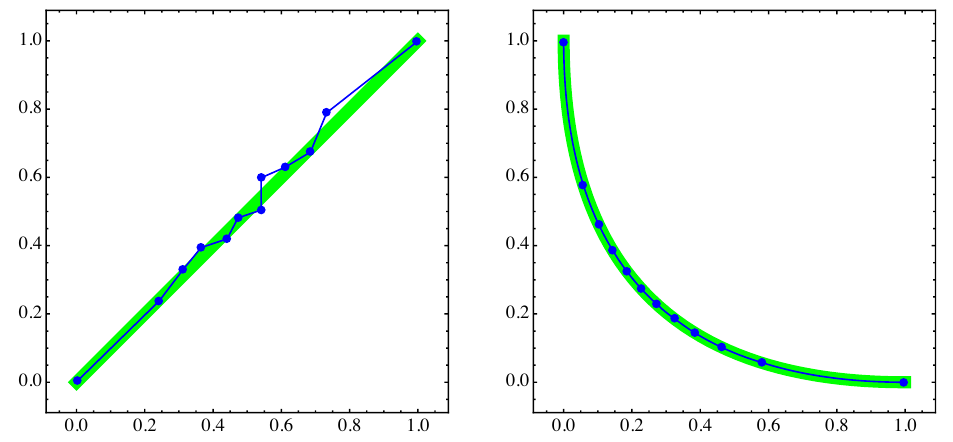
Figure 11. Left: approximations A (blue dots) corresponding to the 500th generation of the MOEA/D algorithm), and B (blue polygon line) of the Pareto set (green thick line) of MOP (12) for n = 2. Right: respective approximations F ( A ) and F ( B ) of the Pareto front for γ = 2.